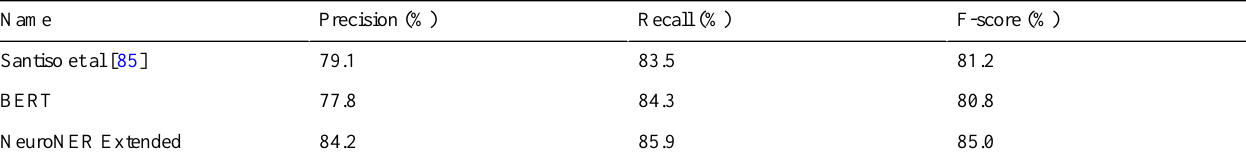
Table 21. Results of cue level and scope detection for the IULA Clinical Record data